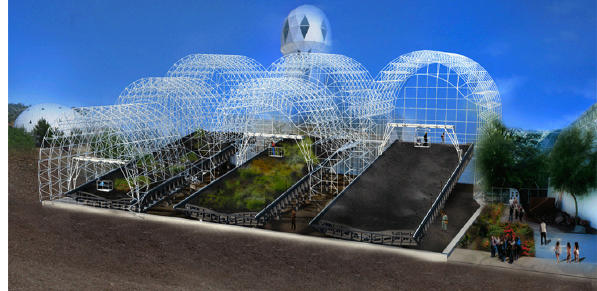
Figure 1. Diagram showing the three identical convergent land- scapes (30m long and 11.15m wide) of the Biosphere 2 LEO con- structed inside an environmentally controlled greenhouse